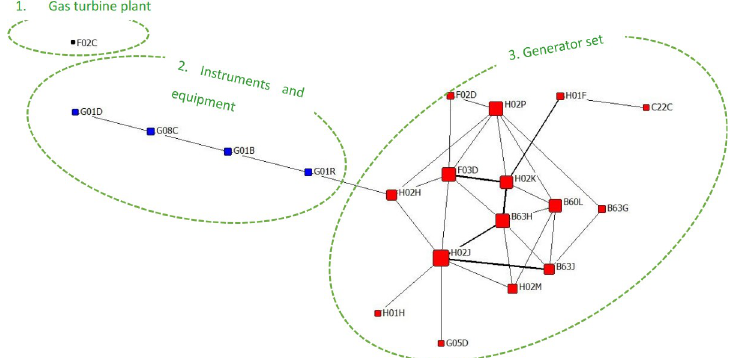
Fig 5. GENE-C patented co-occurrence network